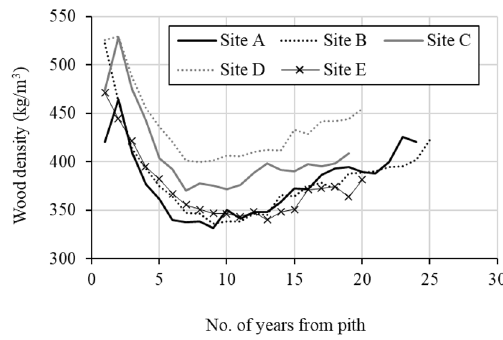
Fig. 7 Variations in the mean wood density at each